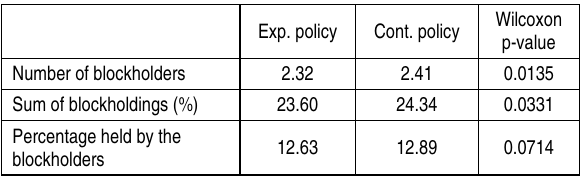
Table 6. Comparison of blockholders’ investments across monetary policy periods Exp.